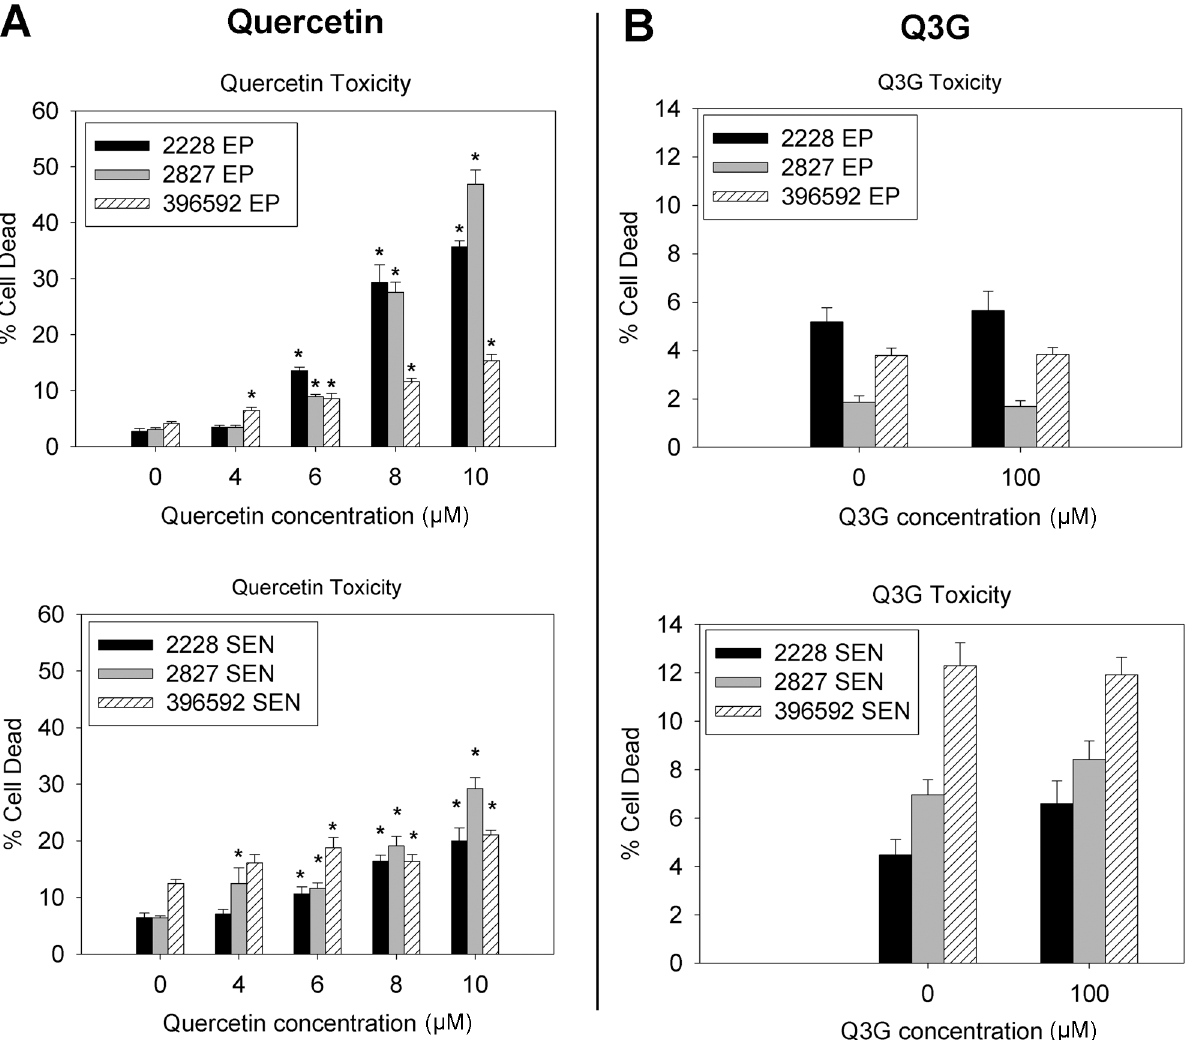
Fig 3. Live-Deadassay for quercetin(A) and Q3G (B) treatment of EP and SEN cells from the same three different donors. Data reflect the percentage of dead cells in responseto different concentrations of quercetin or Q3G. N (cid:21) 6 wells/group, per donor. Approximately 1000 non-fragmented cells were scored for each N. * p < 0.05vs. baselinevalue. One-way ANOVA was used for Q3G data, which are normally distributed. Kruskal-Wallis and Mann-Whitney U tests were used for quercetin treatment to account for